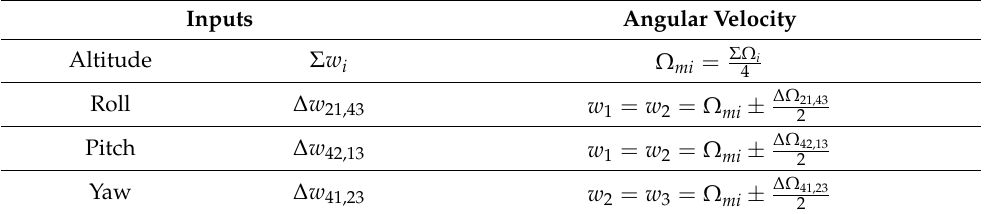
Table 1. The information on control signal separation.